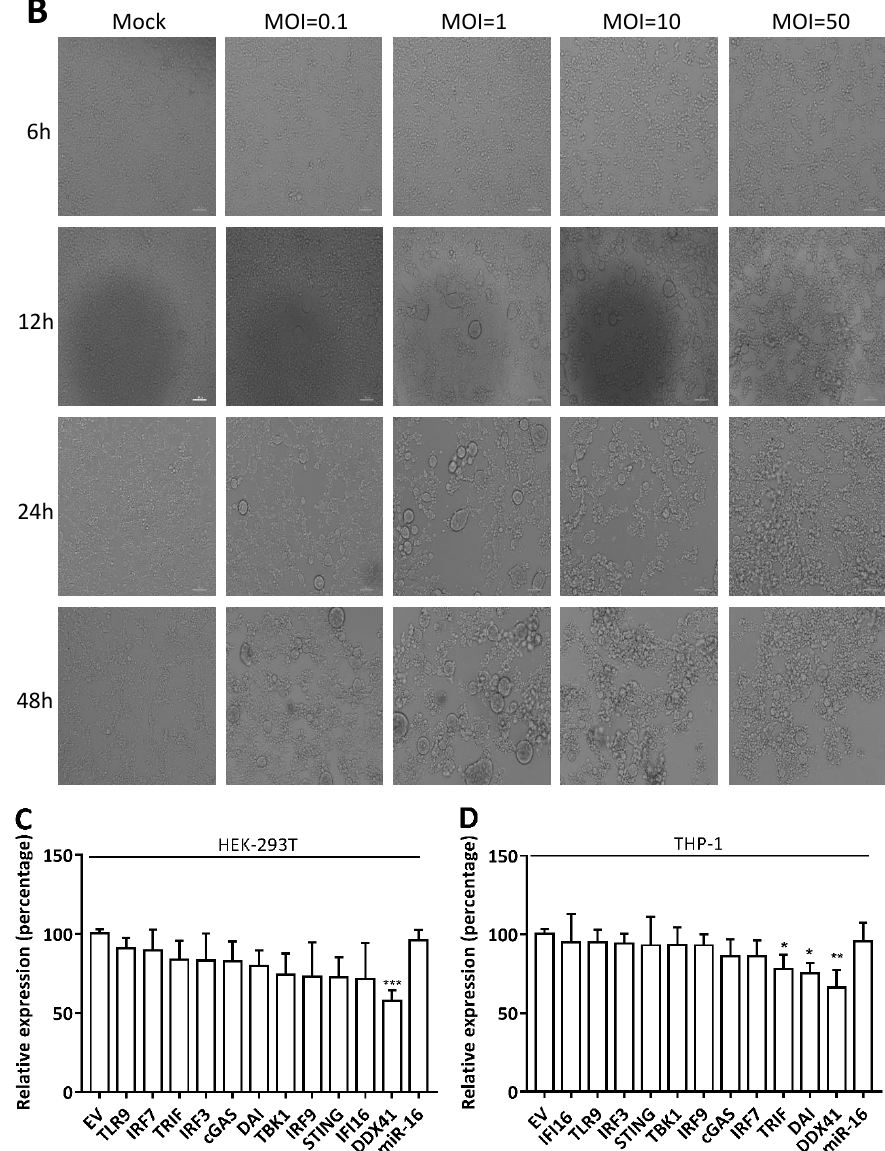
Figure 1. HSV-1 infection attenuated cytosolic DNA sensor reporter expression. ( A ) The scheme of dual-luciferase reporter plasmid construction. pmirGLO vector was digested with Sac I and Xba I, and then inserted into full- length 3’ -UTR sequences of different mRNAs with a correct linker connected with T4 DNA ligase. Hsa-miR-16 complement (pmirGLO-16), as a positive internal control, was constructed by cloning complete complementary sequences into pmirGLO vector. ( B ) Different CPEs of HKE-293T cells infected with HSV-1 at different viral titers and times. HEK-293T cells were infected with HSV-1 at an MOI of 0.1, 1, 10, and 50 or Mock and snapped at the indicated time points. Scale bar, 100 µm. ( C and D ) HEK-293T ( C ) or THP-1 ( D ) cells were transfected with a reporter plasmid, and then infected with HSV-1 or mock. The cells were transfected with 500 ng indicated reporter plasmid. After 24 h of transfection, the cells were infected with HSV-1 at an MOI of 1 or mock for another 24 h, collected, lysed, and assayed for dual-luciferase activity. The values present the percentage of reporter activity with infection compared with that with mock infection, standardized to 100% in the empty vector (EV) group. Data are the means ± SD ( n = 3) from one representative experiment. Similar results were obtained from three independent experiments. * P < 0.05; ** P < 0.01; *** P <